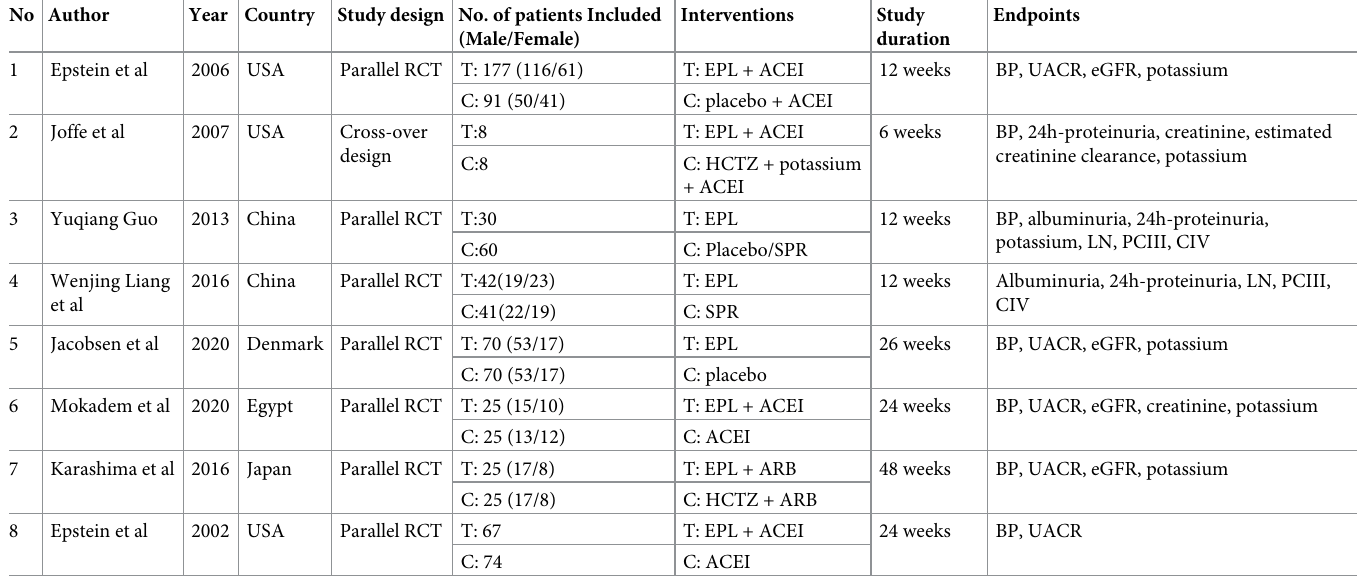
Table 1. The characteristics of the included observational